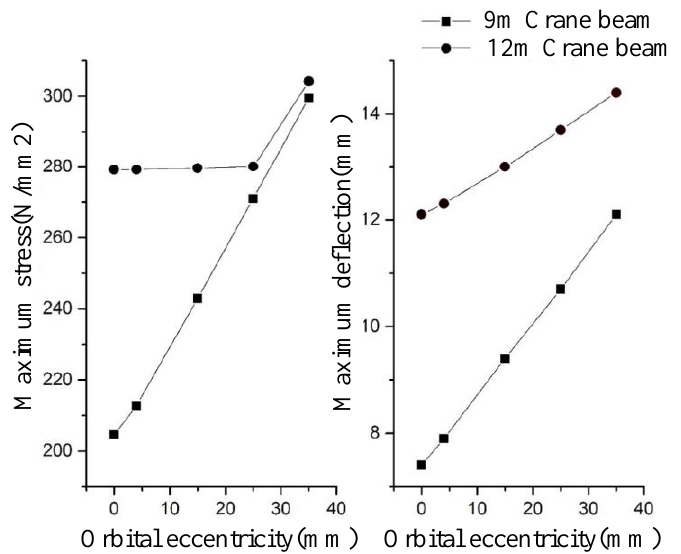
Figure 4. Stress and deflection of crane beam under eccentric track load.